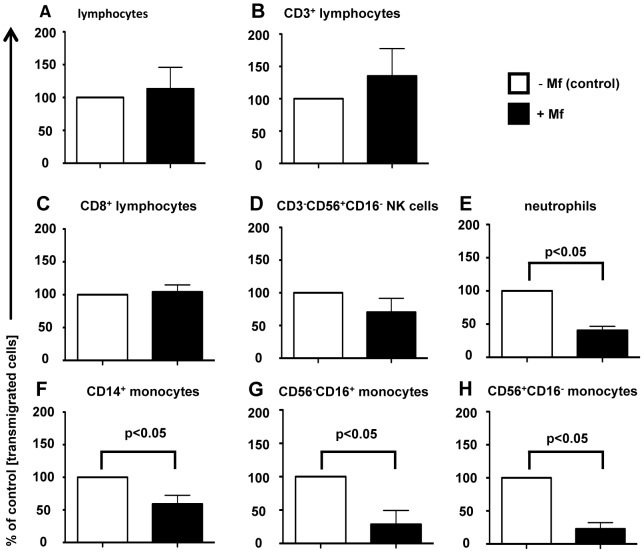
Transendothelial migration of monocytes and neutrophils, but not lymphocytes, is inhibited in the presence of live Mf.TNF-α-prestimulated HUVEC were co-cultured with or without live Mf in inserts of a transmigration assay plate. After 24 hours, 1×106 PBMC or granulocytes were added into the inserts. A further 4 hours later, transmigrated PBMC or granulocytes were harvested from the lower wells and the number of transmigrated (a) total lymphocytes, (b) CD3+ lymphocytes, (c) CD8+ lymphocytes, (d) CD3−CD56+CD16− NK cells, (e) neutrophils, (f) CD14+ monocytes, (g) CD3−CD56+CD16− monocytes and (h) CD3−CD56+CD16+ monocytes were analysed by flow cytometry. Total lymphocytes and neutrophils were defined by FSC:SSC gates of transmigrated cells. The percentage of cells that transmigrated in the presence of Mf was compared to extravasation in Mf absence. Data are shown as the mean and standard deviation per group of eight (a), three (b–d, g–h) or six (e–f) independent experiments. p values were determined using the Student's t test.